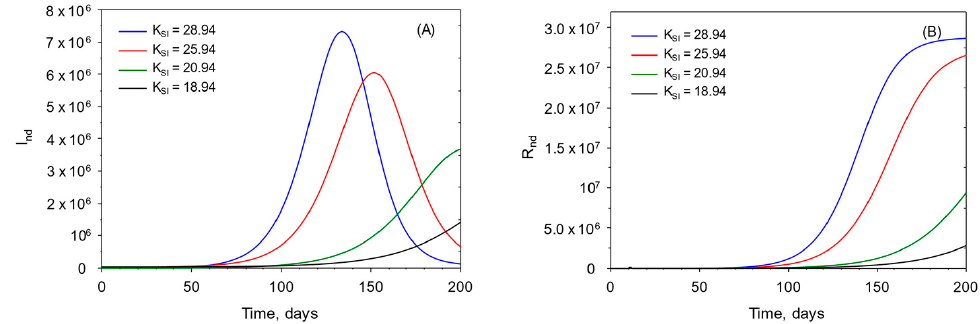
Figure 5. Calculated plots of undetected, infected ( A ) and undetected, recuperated ( B ) for increasing values of the basic infectivity coefficient, K SI .